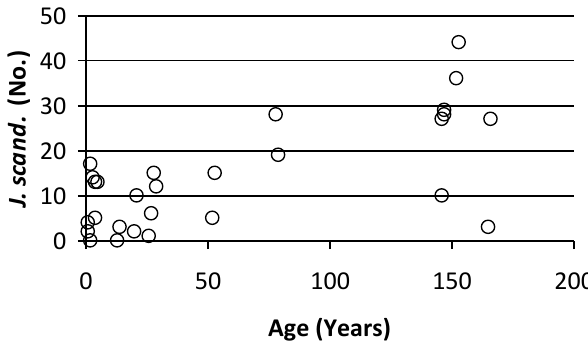
Figure 2. Relationship between age of the beech stands and num- ber of J. scandinavius individuals (combined 2009 and 2010); r = 0 . 949, p < 0 .